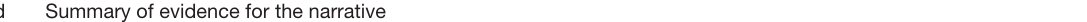
Table 1. Summary of evidence on the narratives Narrative shorthand Summary of evidence for the